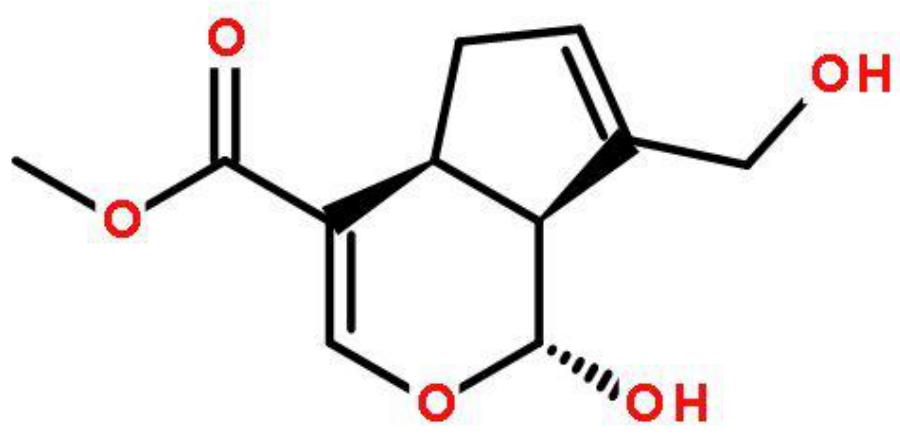
Figure 1. Chemical structure of gelatin.